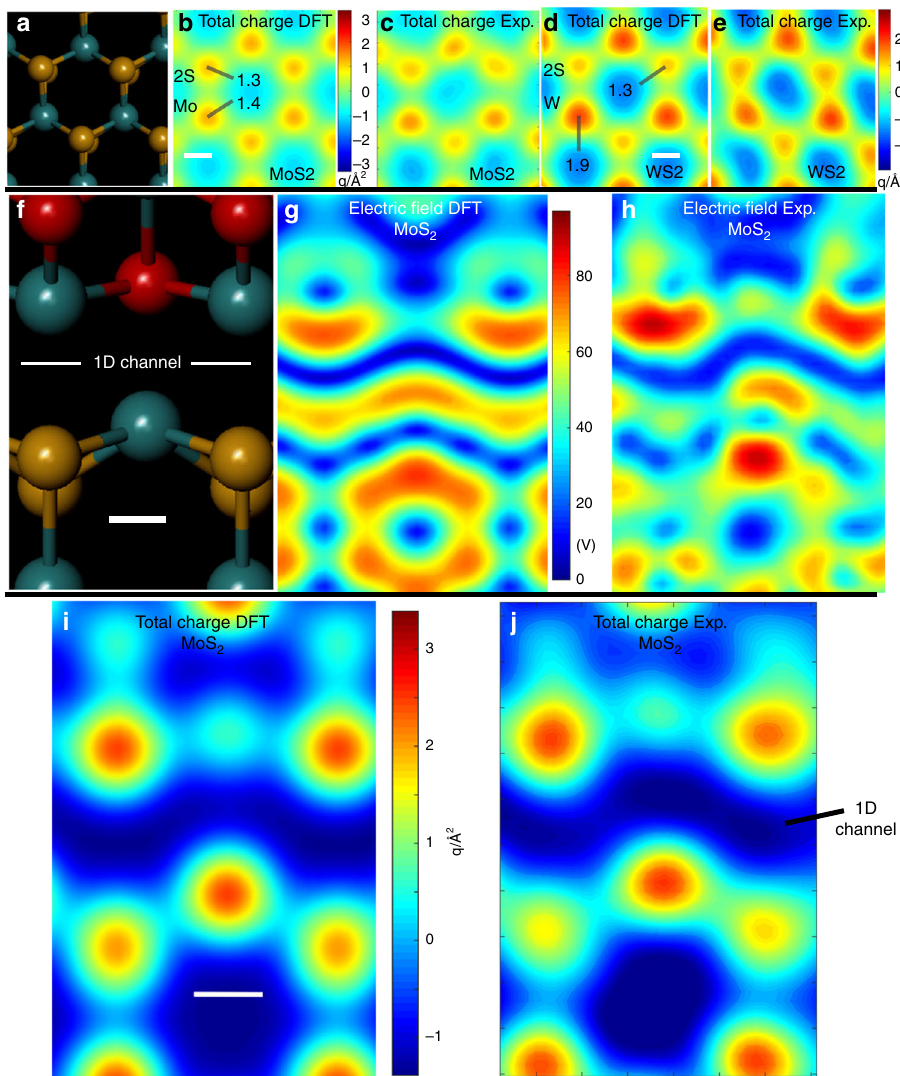
Fig. 3 High-resolution analysis of electric fi eld and total charge around pristine WS 2 and a 1D line vacancy in MoS 2 . a Atomic model of MoS 2 , ( b ) total charge map from DFT calculations for MoS 2 (scale bar indicates 0.1 nm and is applicable to panels ( a – e )). Units are in elementary charge per Angstrom 2 and c experimental total charge map for MoS 2 . d Total charge map from DFT calculations for WS 2 (scale bar indicates 0.1 nm and is applicable to panels (d) and e and e total experimental charge map of WS 2 . f Atomic model of the 1D channel Mo − Mo bonding region in MoS 2 line defects (scale bar in panel ( f) indicates 0.1 nm and is applicable to panels ( f ) − ( h )). g | E ┴ | map calculated using DFT and h experimental | E ┴ | map for MoS 2 . i Total charge map calculated from DFT for MoS 2 from the atomic model in panel ( f ) (scale bar indicates 0.1 nm and is applicable to panels ( i ) and j and j corresponding total experimental charge